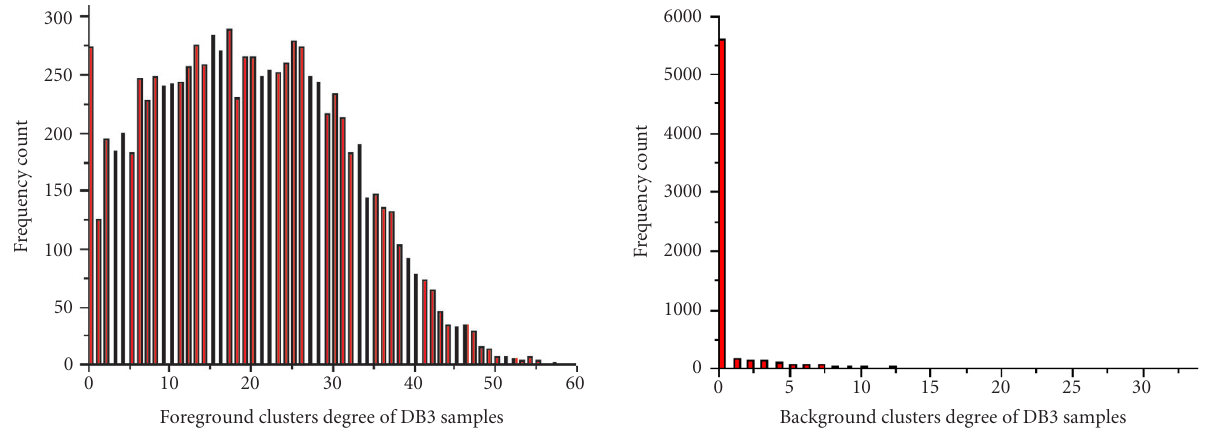
Figure 5: The block clusters degree CluD of the samples. The horizontal coordinate represents the value of the block clusters degree, while the vertical coordinate represents the frequency count of the value.